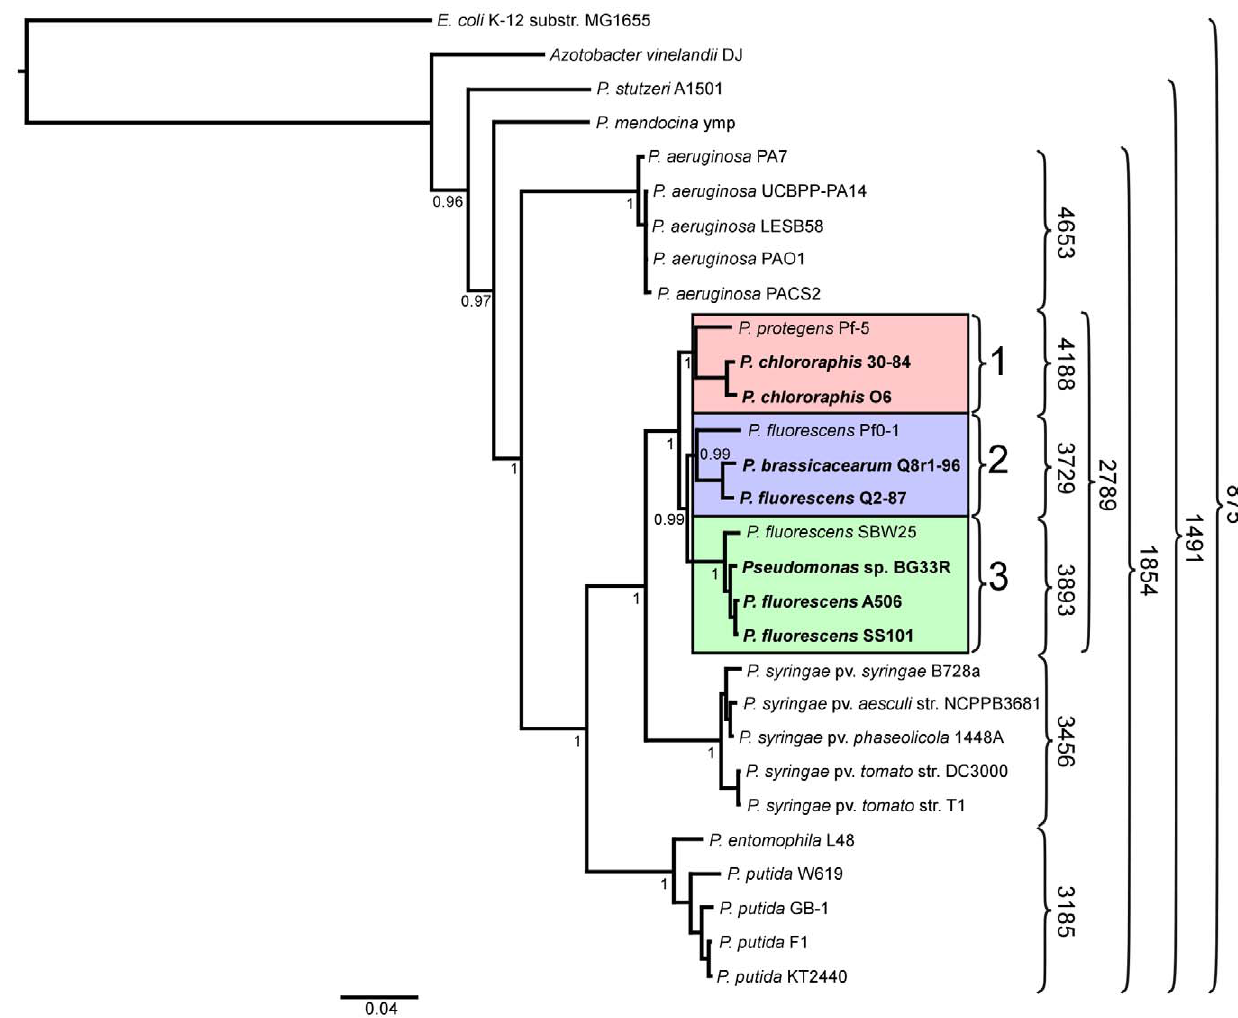
Figure 1. Phylogenetic tree depicting the relationships of sequenced strains of Pseudomonas spp. The tree is based on concatenated alignments of ten core housekeeping genes: acsA , aroE , dnaE , guaA , gyrB , mutL , ppsA , pyrC , recA , and rpoB , and was generated using the MrBayes package [152]. The interior node values of the tree are clade credibility values, which represent the likelihood of the clade existing, based on the posterior probability values produced by MrBayes. Strains in the P. fluorescens group fall within a single clade comprised of three sub-clades, which are numbered 1 to 3 and highlighted pink, blue and green, respectively. Strains sequenced in this study are in bold font. Numbers on the right of the figure represent the size of the core genome of the strains included within the curved